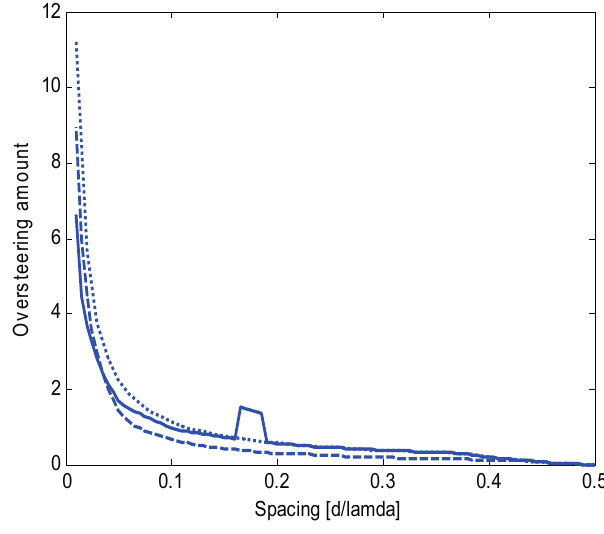
Figure 8. Oversteering amount, ε , that provides the maximum constrained directivity for an end-fire array of N = 8 transducers, which is obtained by imposing WNG ≥ 0 dB for three weighting windows: optimum weights (solid line), uniform weights (dashed line), and Taylor’s weights (dotted